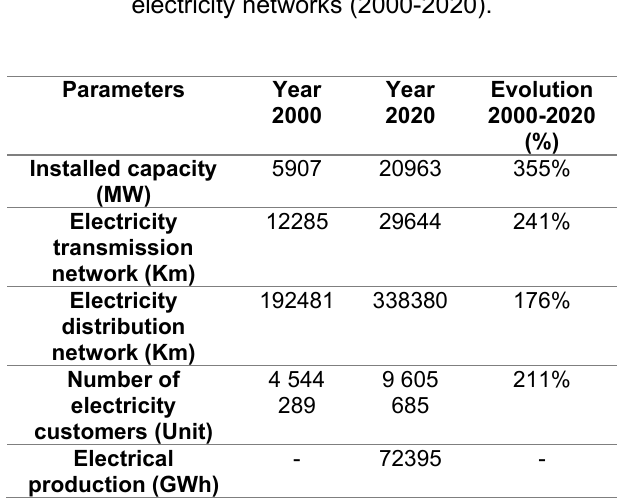
Table 5. Evolution of the main parameters of the 3 electricity networks